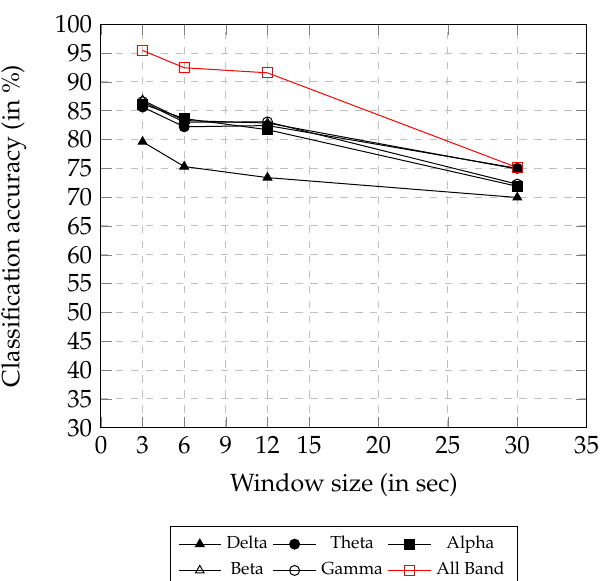
Figure 5. Valence classification accuracy on varying window size using AsMap+CNN features.